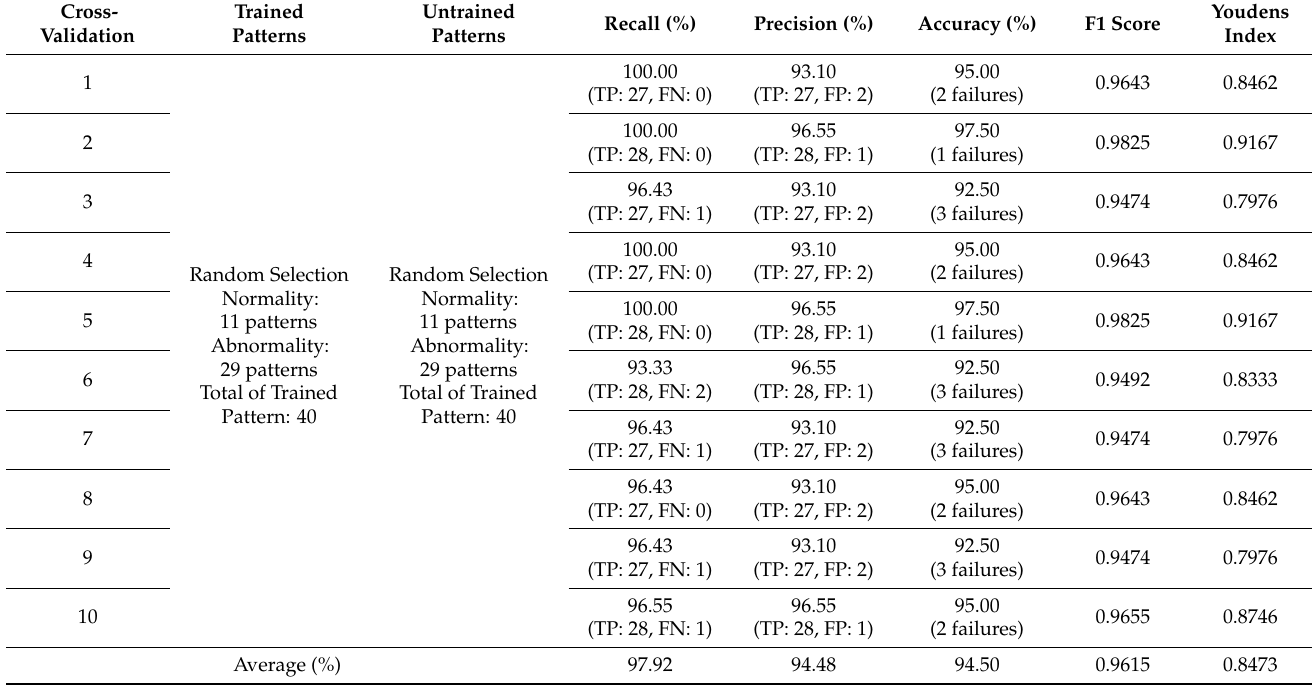
Table 3. Experimental results of tenfold cross-validation for the proposed 1D CNN-based classifier. Cross-